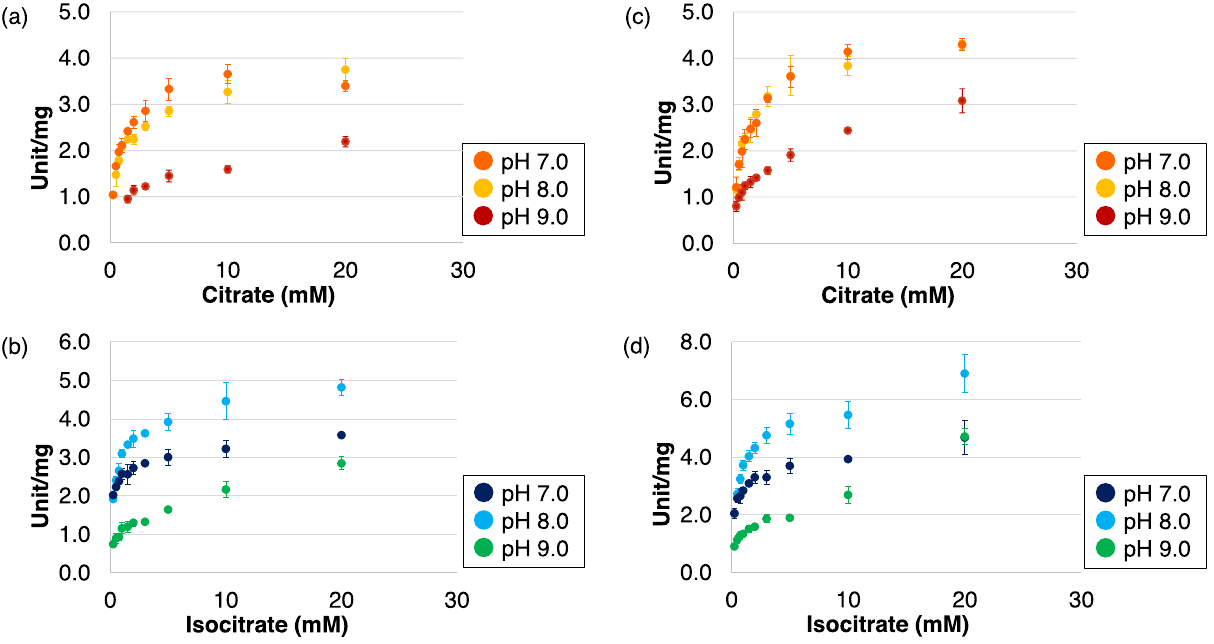
Figure 4. Saturation curves displaying the activities of Sy AcnB at each pH. The experiment was performed using ( a ) trisodium citrate dihydrate and ( b ) dl-isocitrate trisodium salt hydrate in Tris–HCl buffer pH 7.0, 8.0, and 9.0 at 30 °C. The experiment was repeated using ( c ) trisodium citrate dihydrate and ( d ) dl-isocitrate trisodium salt hydrate in Tris–HCl buffer pH 7.0, 8.0, and 9.0 at 45 °C. Mean ± SD values were calculated from three independent experiments. Sy AcnB, Synechocystis sp. PCC 6803 aconitase B; SD, standard deviation.